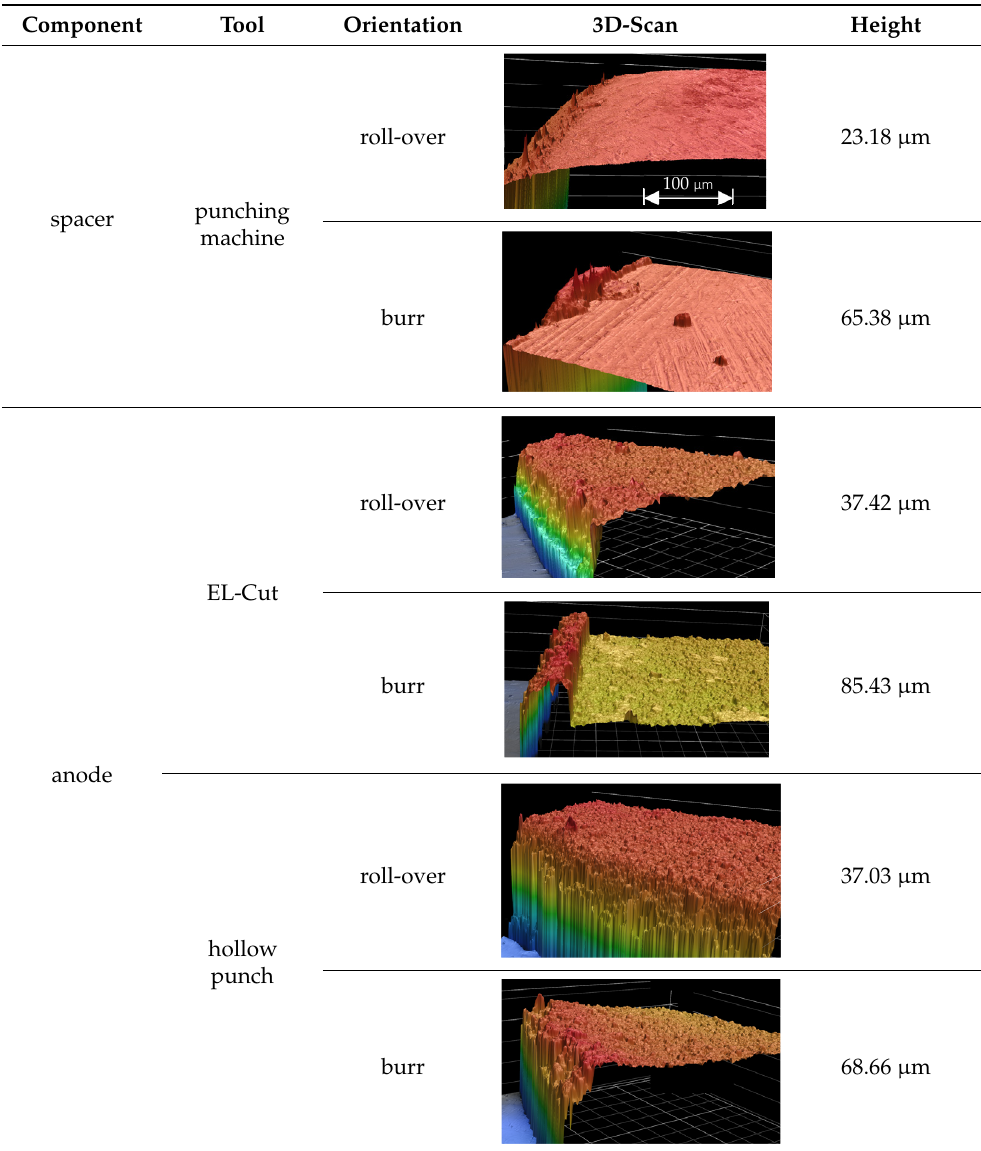
Table 3. Tool impact visualized with laser-scanning microscope (zoom: 20×) .